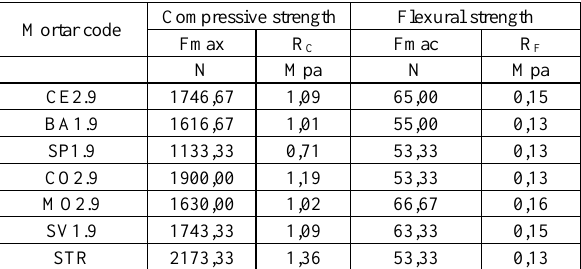
Table 9. Compressive strength and flexural strength test results, produced by the